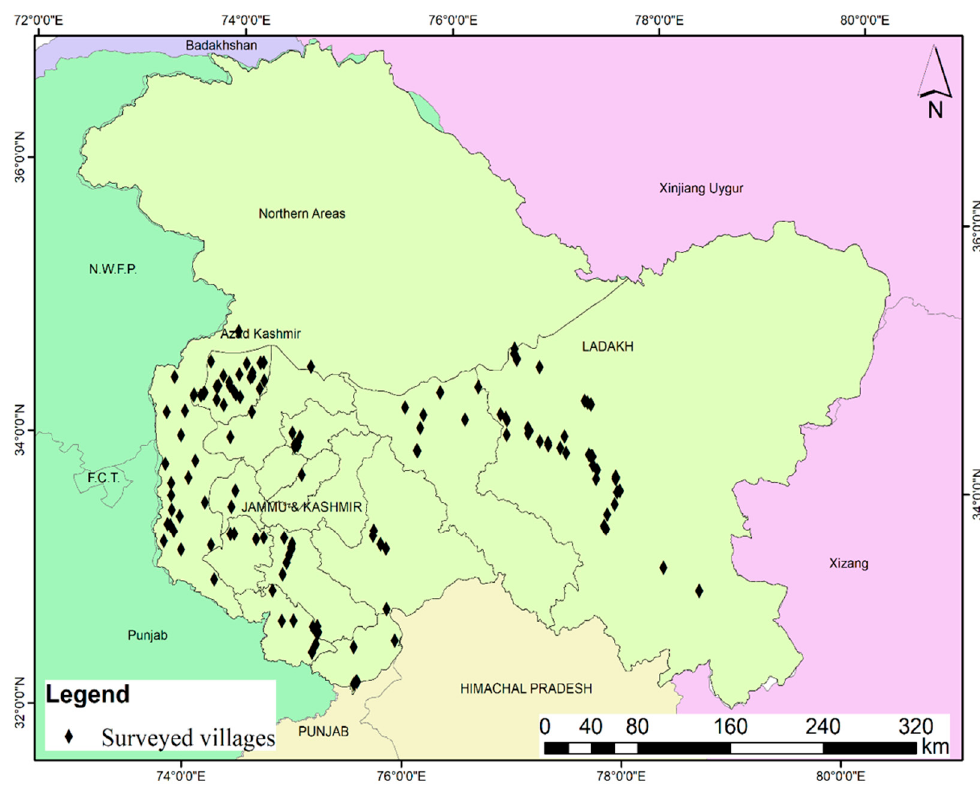
Figure 1. Political map of Jammu and Kashmir (J&K) with neighboring countries, and points showing the surveyed villages in the erstwhile princely state of Jammu and Kashmir. Azad Kashmir region is administrated by Pakistan authorities whereas the Jammu, Kashmir and Ladakh regions are administrated by Indian authorities. The surrounding countries of the region are represented by different colors, with purple representing China and green representing Pakistan while the rest of India is shown in cream.